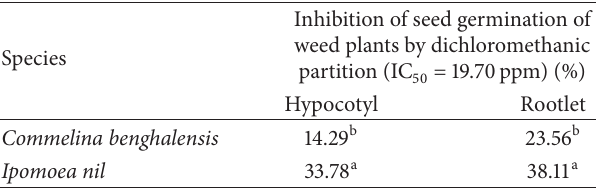
Table 6: Inhibition of weed plants ( Commelina benghalensis and Ipomoea nil ) growth of hypocotyls and rootlets by dichloromethanic partition of seed extract of cultivar BR-1 of Arachis hypogaea .